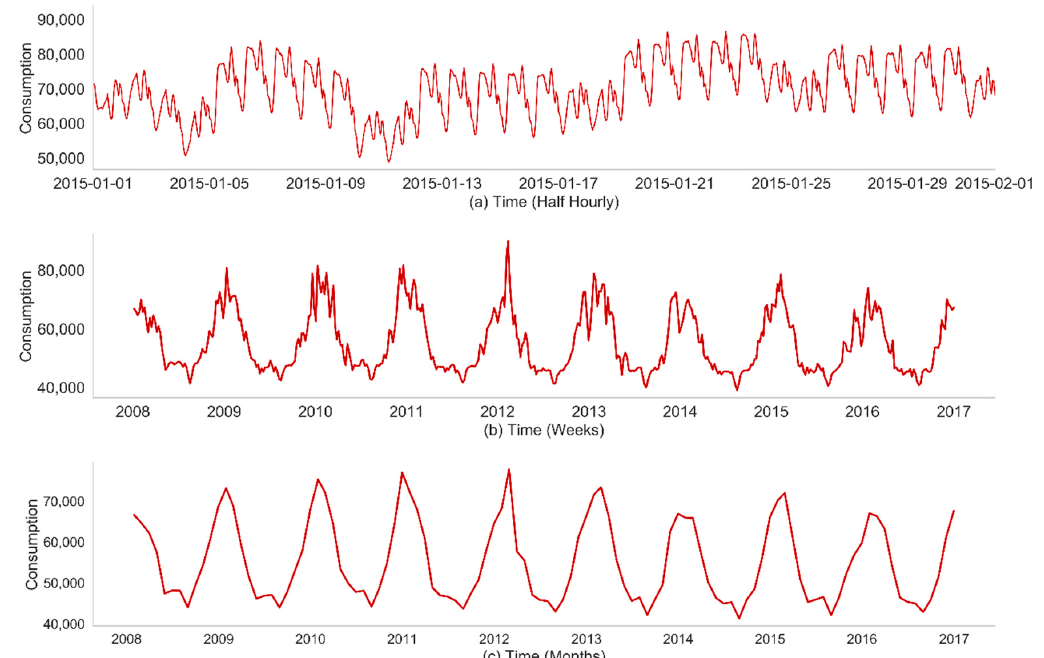
Figure 4. Proposed forecasting methodology.